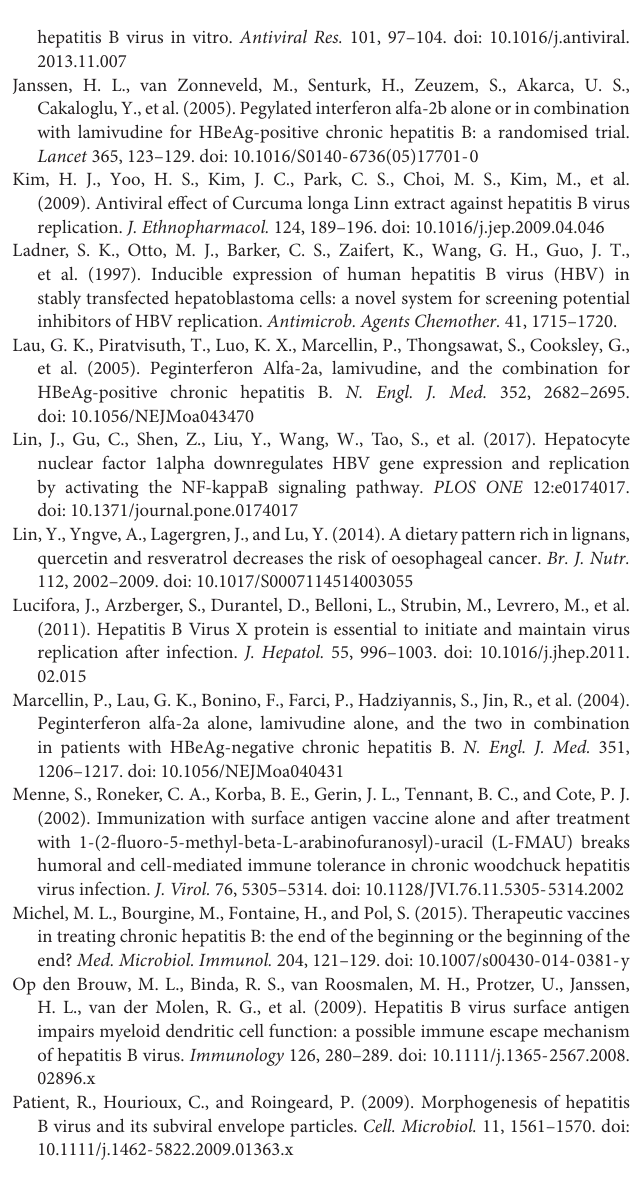
FIGURE S3 | Lettuce extracts S15 suppresses HBV viral antigen (A,B) , replication (C,D) and transcription (E,F) in the absence or presence 3TC and IFNa-2b in HepAD38 cells. HBsAg and HBeAg levels in culture supernatants were measured using an electrochemical illuminescent immunoassay (A,B) . HBV replication intermediates were extracted and detected by Southern blot hybridization (C) and quantified using fluorescence quantitative PCR (D) . Viral RNAs were examined by Northern blot (E) and quantified using fluorescence quantitative PCR (F) . All values are expressed as percentages relative to untreated control. RC, relaxed circular DNA; SS, single-stranded DNA. β -actin served as the DNA loading control and 18S/28S RNAs served as the RNA loading control. Statistical significance was calculated using student’s t -test. Ns, not significant, ∗ P < 0.05, ∗∗ P < 0.005, ∗∗∗ P < 0.0005, ∗∗∗∗ P <